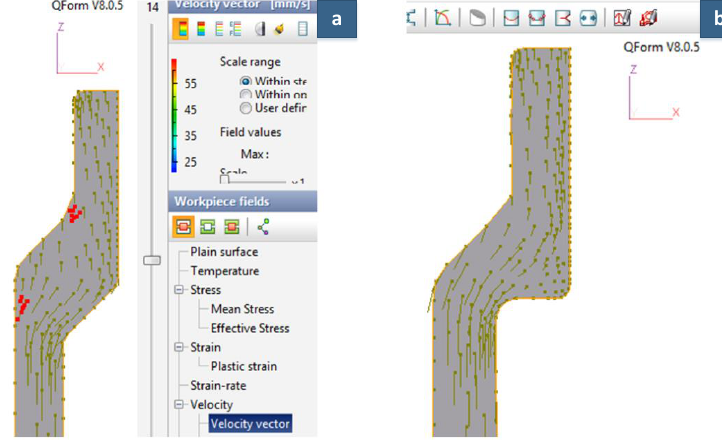
Figure 9. Metal flow with ( a ) one-step stamping and ( b ) two-step stamping.